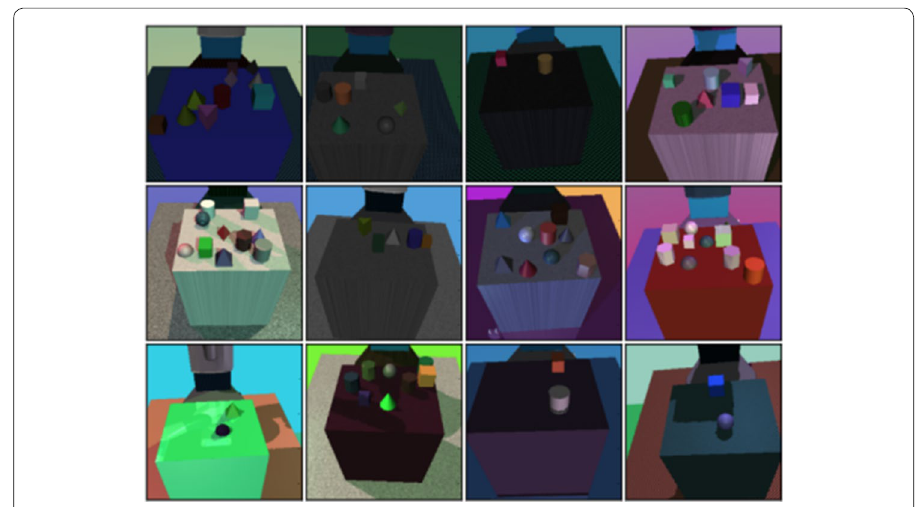
Fig. 27 Examples of different styles simulated by Tobin et al.